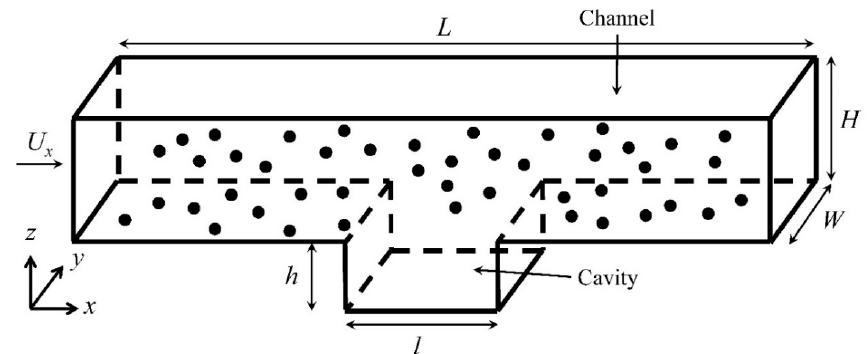
Figure 24. Schematic of the sedimentation system.